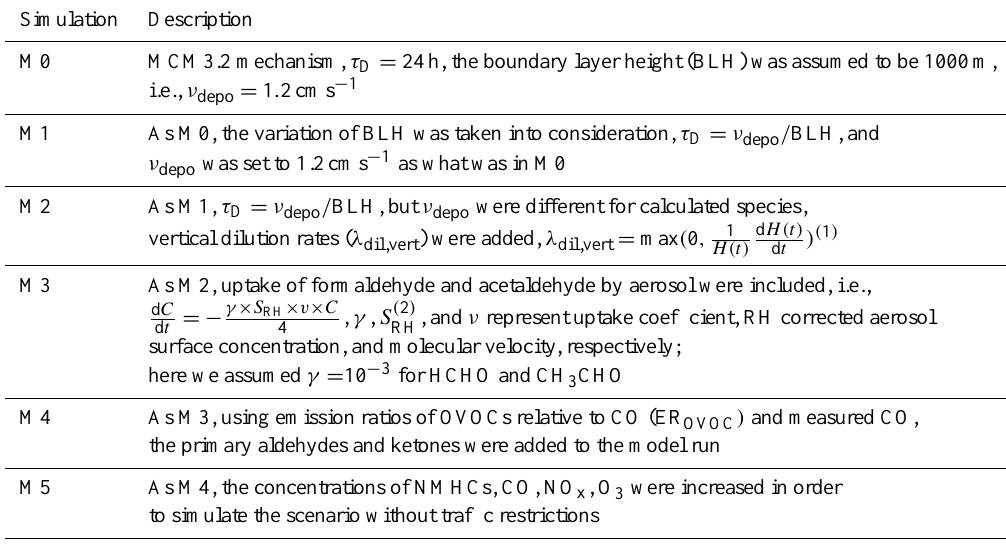
Table 3. Model scenarios performed in OVOC simulations during the CAREBEIJING 2008.